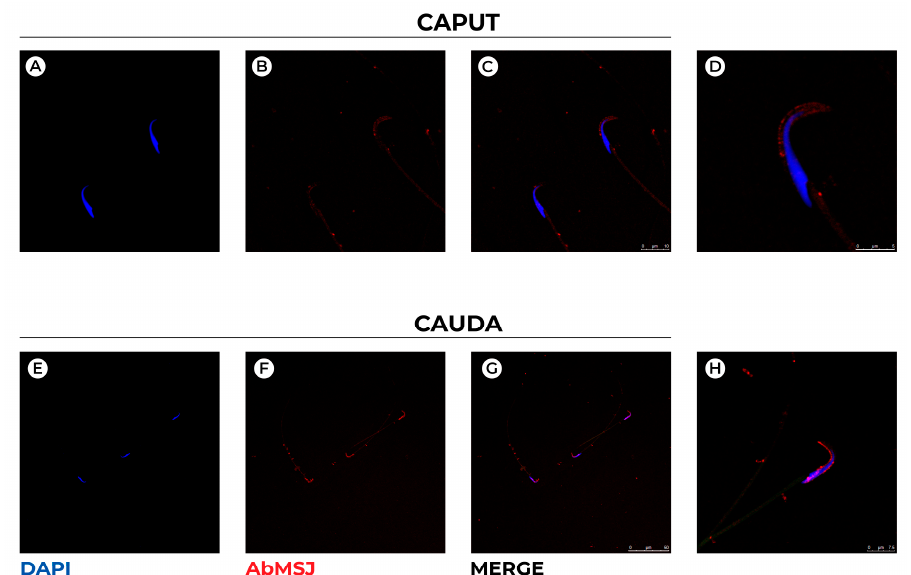
Figure 3. Confocal representative images showing immunofluorescence staining for MSJ-1 (AbMSJ, red) in rat spermatozoa collected from epididymis caput ( A – D ) and cauda ( D – H ). ( D , H ) represent higher magnification of spermatozoa showing MSJ-1 different distribution in caput and cauda epididymis. DAPI (blue) was used to counterstain sperm cell nuclei. Scale bar: 5 µ m ( A – C ) ; 7.5 µ m ( D – F ).